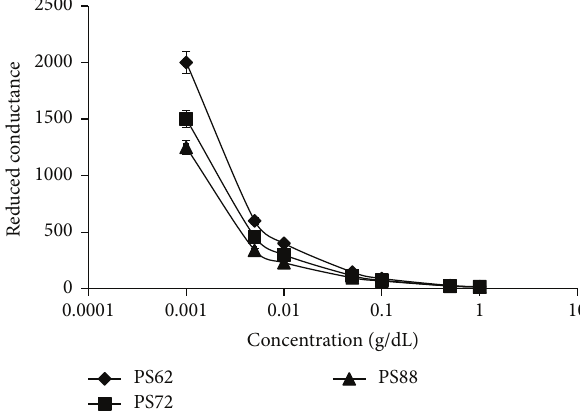
Figure 10: Conductance of various polymer samples measured in water as a function of their concentration at 25 ∘ C.